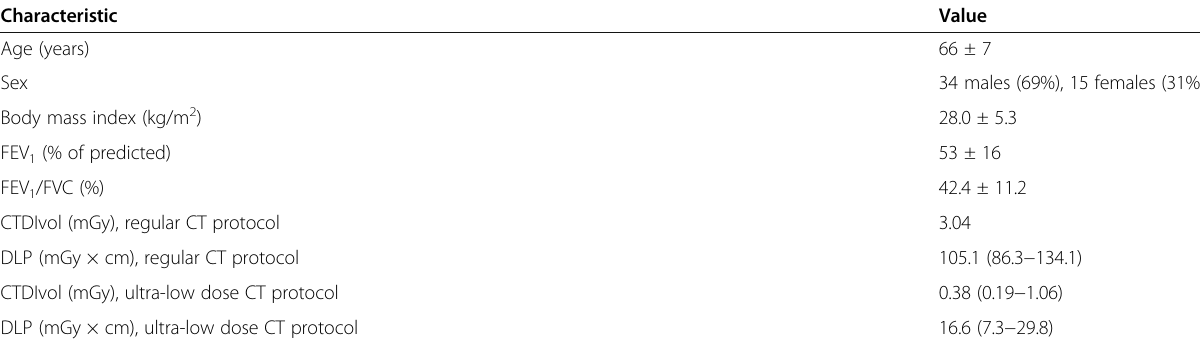
Table 1 Patient cohort characteristics ( n = 49) Characteristic